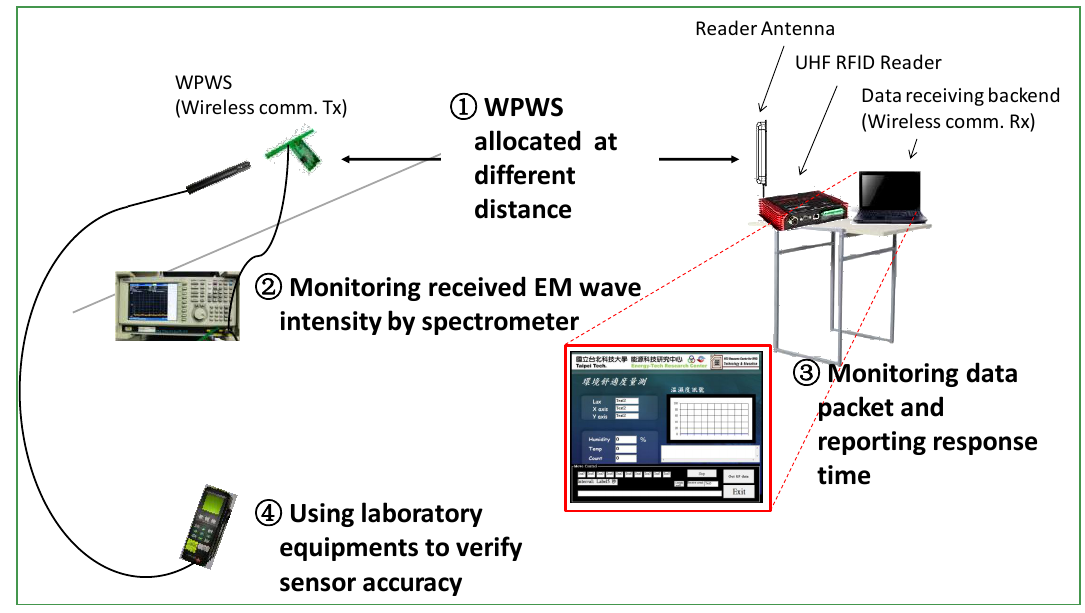
Figure 14. Experimental Setup 1: Four steps were followed to test two performance indices of the WPWS: stability of harvesting energy, and sensor